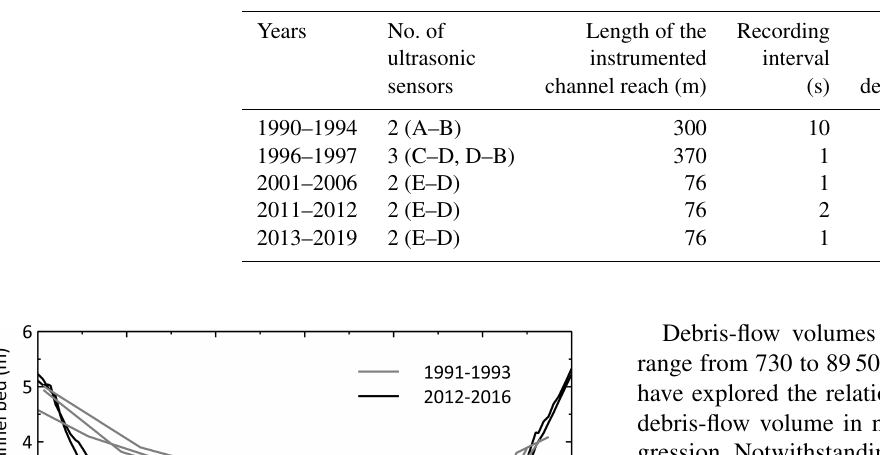
Table 3. Basic characteristics of the debris-flow monitoring system; the letters in the second column refer to the instrumented cross-sections shown in Fig. 1.